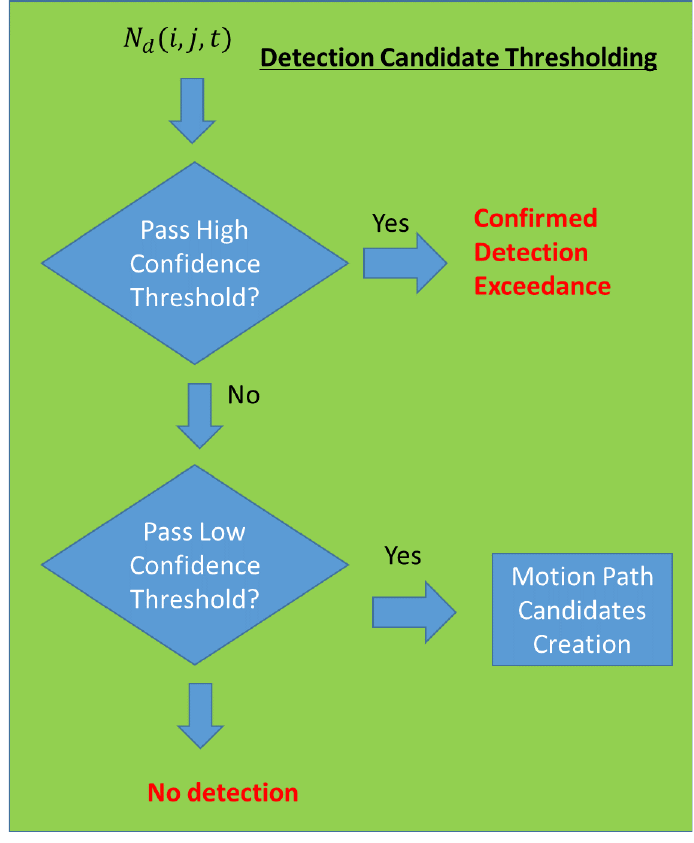
Figure 4. Detection Candidate Thresholding.